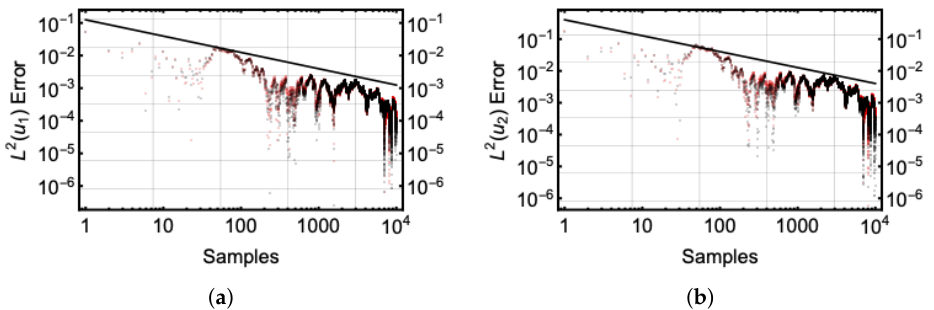
Figure 14. Convergence graph of absolute value of the error of the Monte Carlo (Black) and sampled Galerkin (Red) solutions. The upper bound is the standard σ / ( a ) L 2 ( u 1 ) : Monte Carlo convergence and ( b ) L 2 ( u 2 ) : Monte Carlo